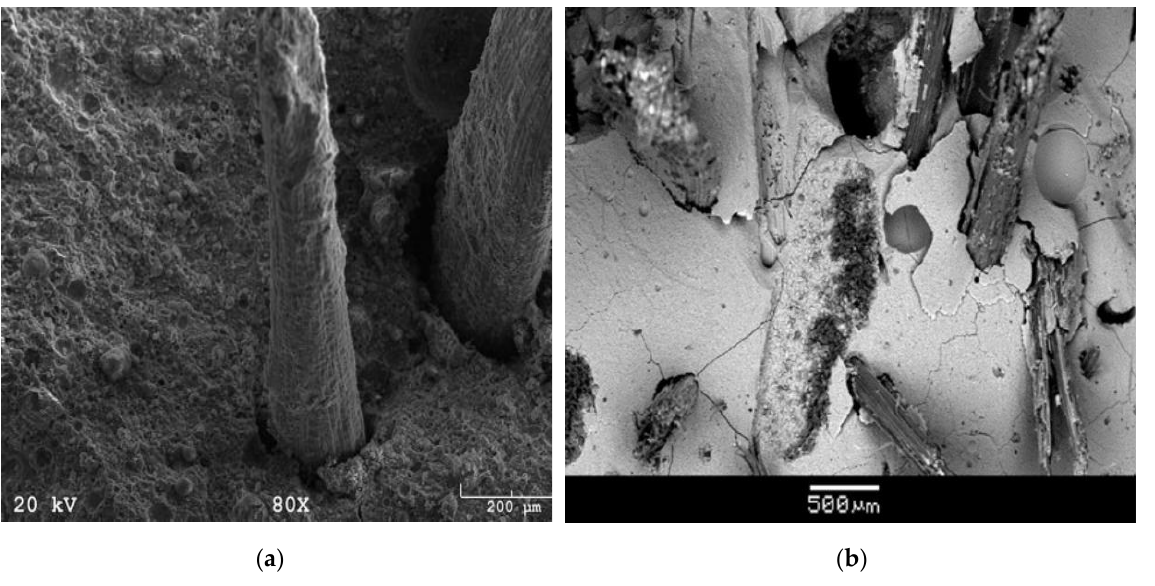
Figure 8. Microstructure of fiber in matrix after bending ( a ) Coir fiber; [98] ( b ) Bamboo fiber [110].